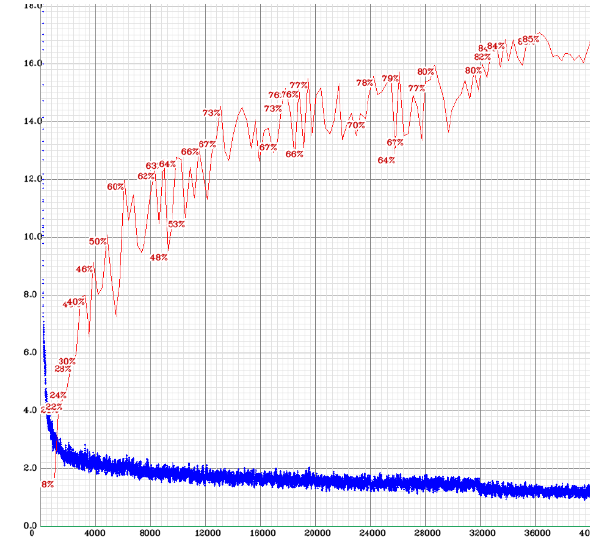
Figure 5 . Some samples of pavement distress recognition results using proposed deep learning